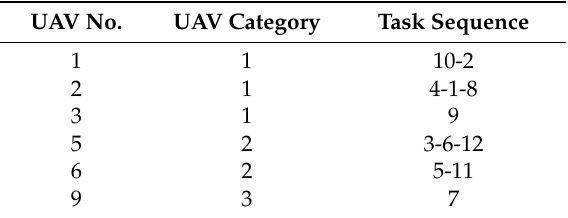
Table 6. Flight Sequence of Each UAV in Scenario